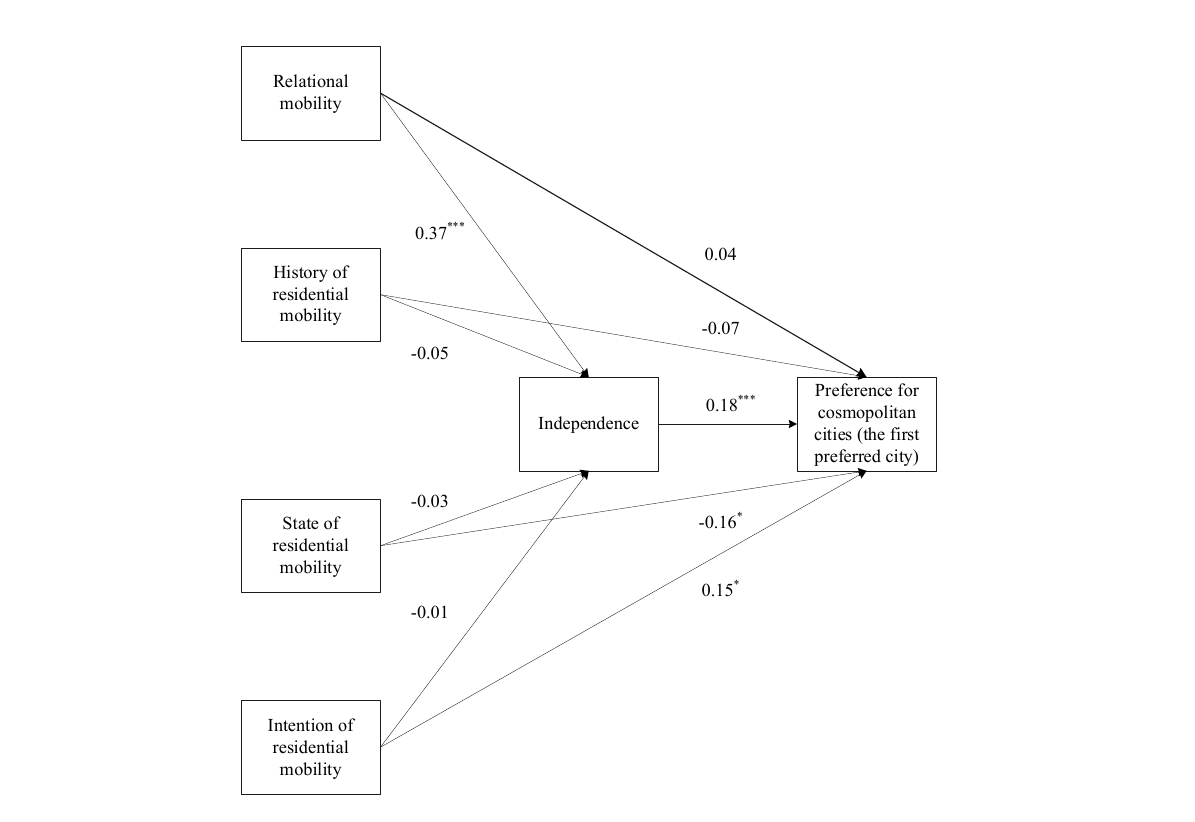
FIGURE1 The mediating role of independence in the association between mobility and preference for cosmopolitan cities (the first preferred city), with standardized coefficients. Results of covariates are not shown for the purpose of simplicity; ∗∗∗ p < 0.001, ∗ p <